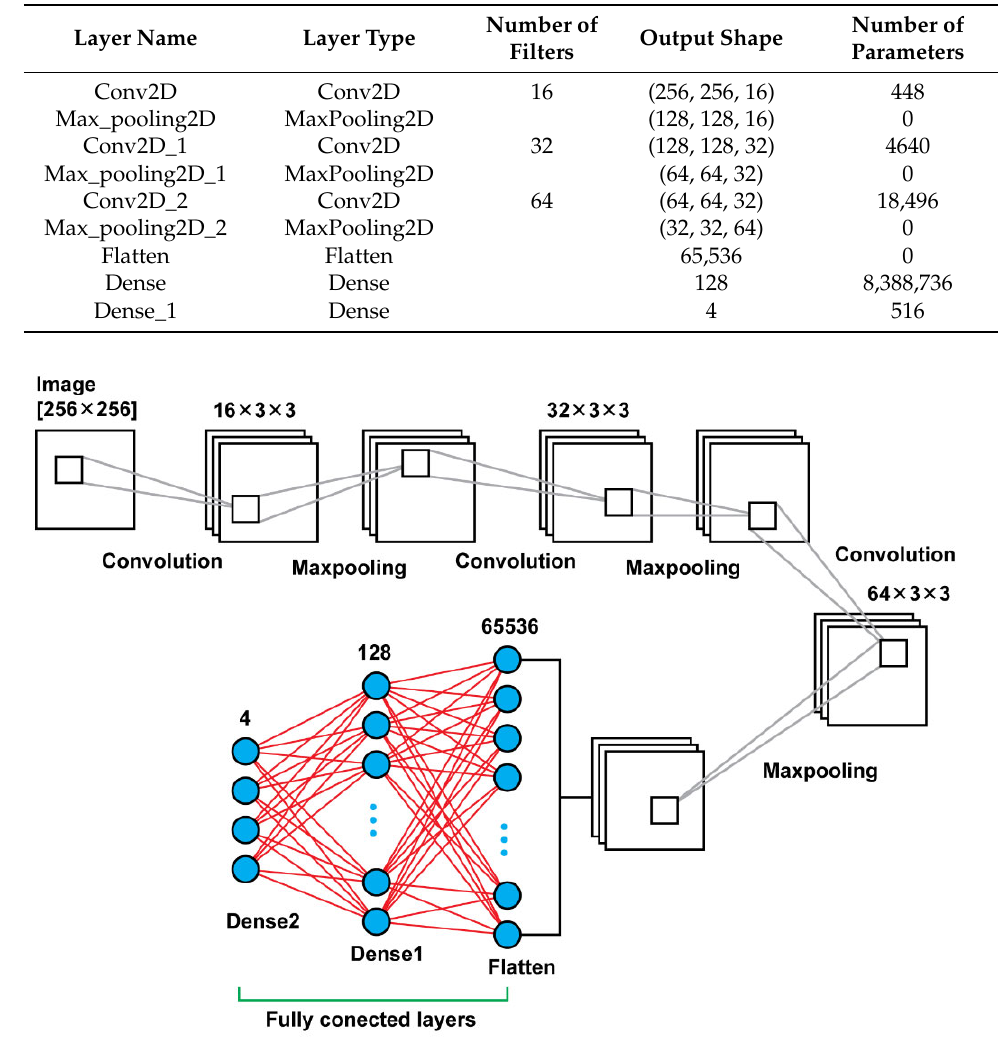
Figure 3. Model 1 architecture. Figure 3. Model 1 Table 1. Model 1 summary.